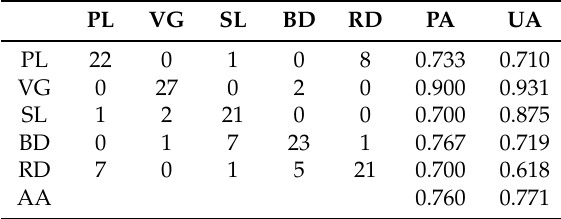
Table 15. Confusion matrix of the CART in the third area.